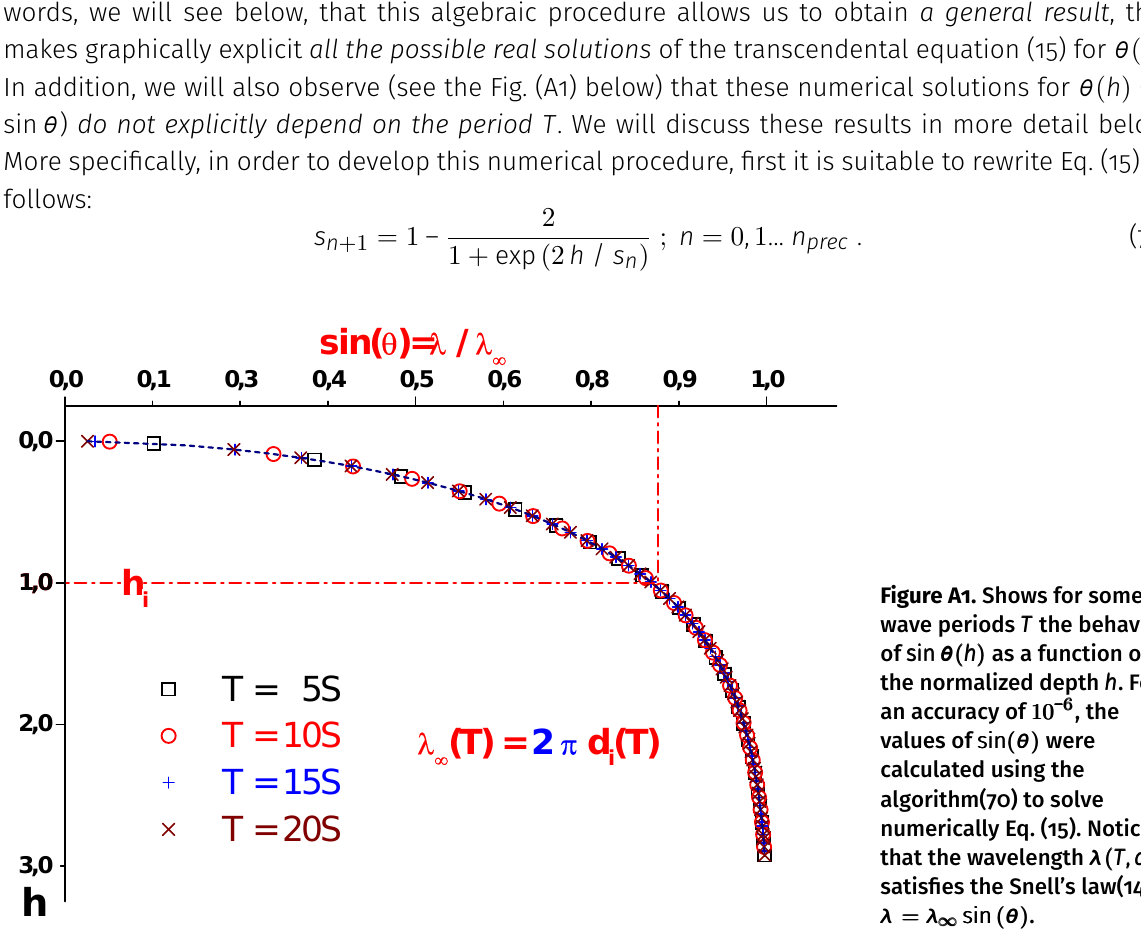
Figure A1. Shows for some wave periods TTT the behavior of sin θ ( h ) sin θ ( h ) sin θ ( h ) as a function of the normalized depth hhh . For an accuracy of 10 – 6 10 – 6 10 – 6 , the values of sin ( θ ) sin ( θ ) sin ( θ ) were calculated using the algorithm(70) to solve numerically Eq. (15). Notice that the wavelength λ ( T , d ) λ ( T , d ) λ ( T , d ) satisfies the Snell’s law(14), λ = λ ∞ sin ( θ ) λ = λ ∞ sin ( θ ) λ = λ ∞ sin ( θ )